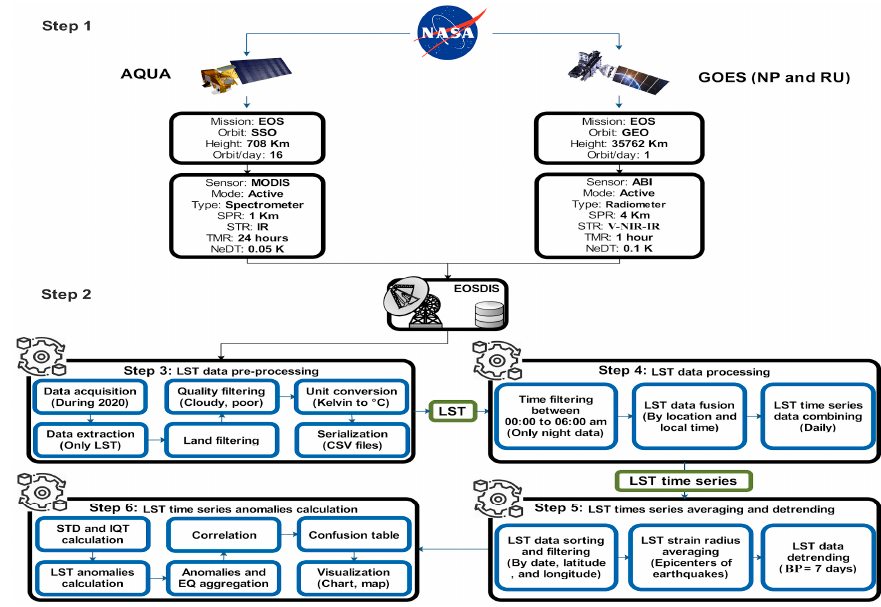
Figure 1. The general architecture of LST data processing and anomalies calculations. Table 1. LST Satellites Data Sources.